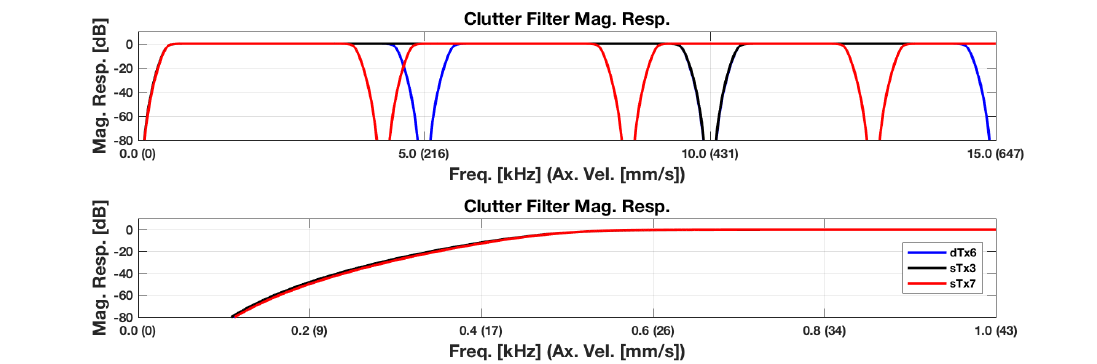
Figure 4. Clutter filter magnitude response. One should note the induced periodicity of the stop bands. This periodicity is due to the design decision to filter the LRI polyphase channels independently, as explained in Section 2.1.4. The repeated notch locations of the filter are located at integer multiples of 2 N T / f N . These notch locations correspond to the frame rates of HRIs, and consequentially the individual LRI polyphase channel frame rates as well. A zoomed in version is displayed below to help visualize stop band